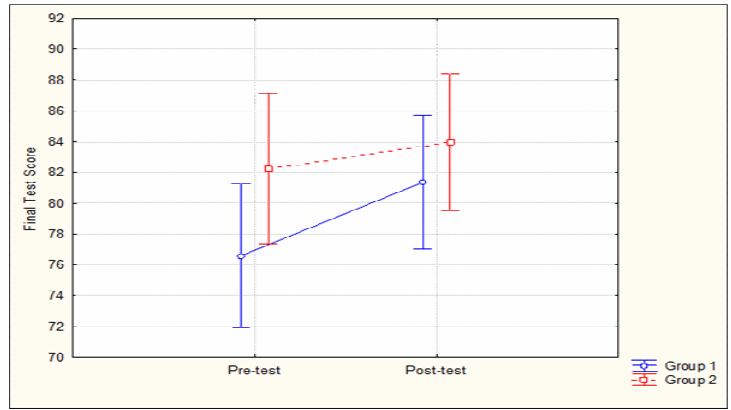
Figure 3. Final pre-test and post-test scores for both groups.